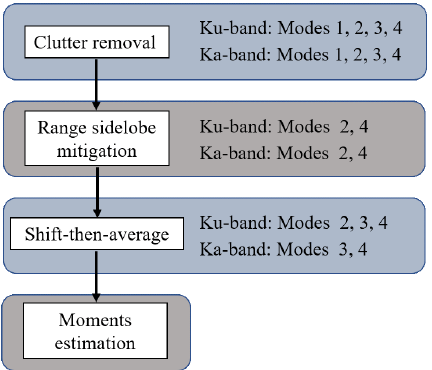
Table 3. The same as in Table 2 but for the Ka